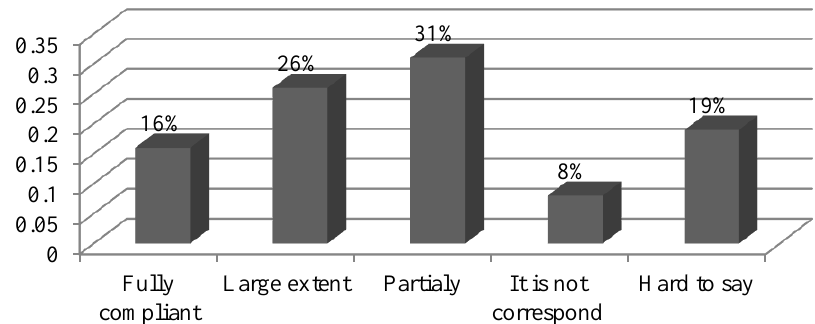
Fig. 1 . Conformity of the graduates’ professional knowledge, skills